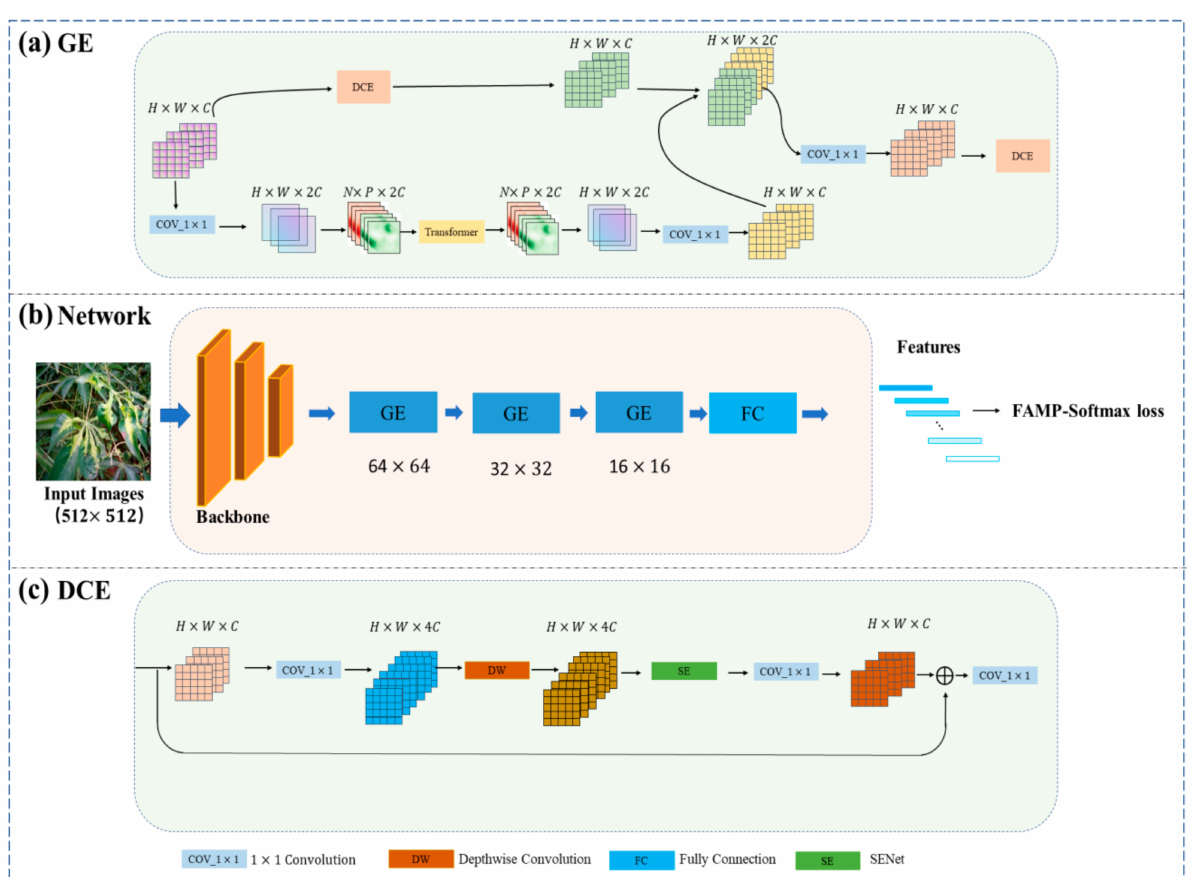
Figure 1. The overall architecture of our method. The images are sequentially processed by the backbone (first two stages of ResNet18) and GE, and the extracted features are then fed into the fully connected layer and our proposed loss function FAMP-Softmax loss to obtain the final classification results. 512 × 512 denotes the size of the input images, and 64 × 64, 32 × 32, and 16 × 16 denote the size of the feature